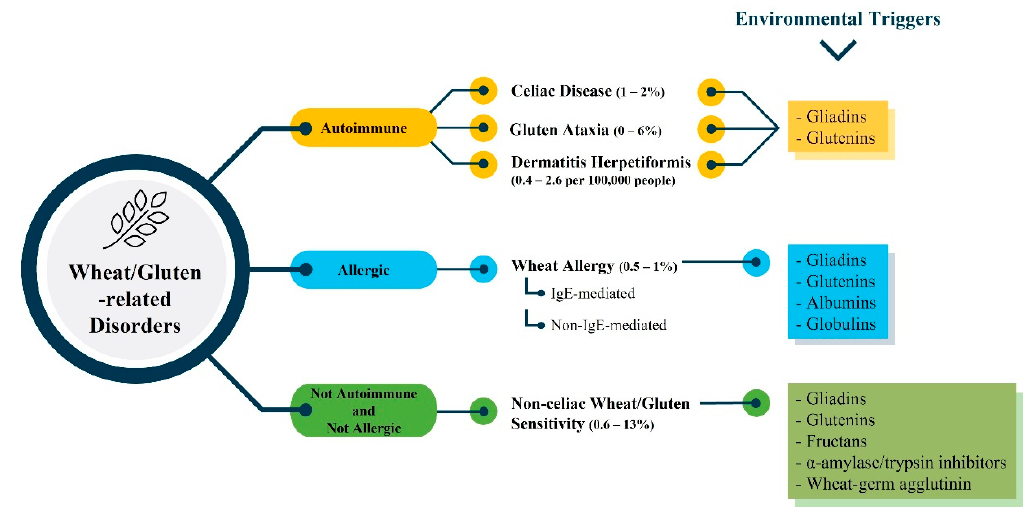
Figure 2. Wheat/gluten-related disorders, their prevalence and environmental